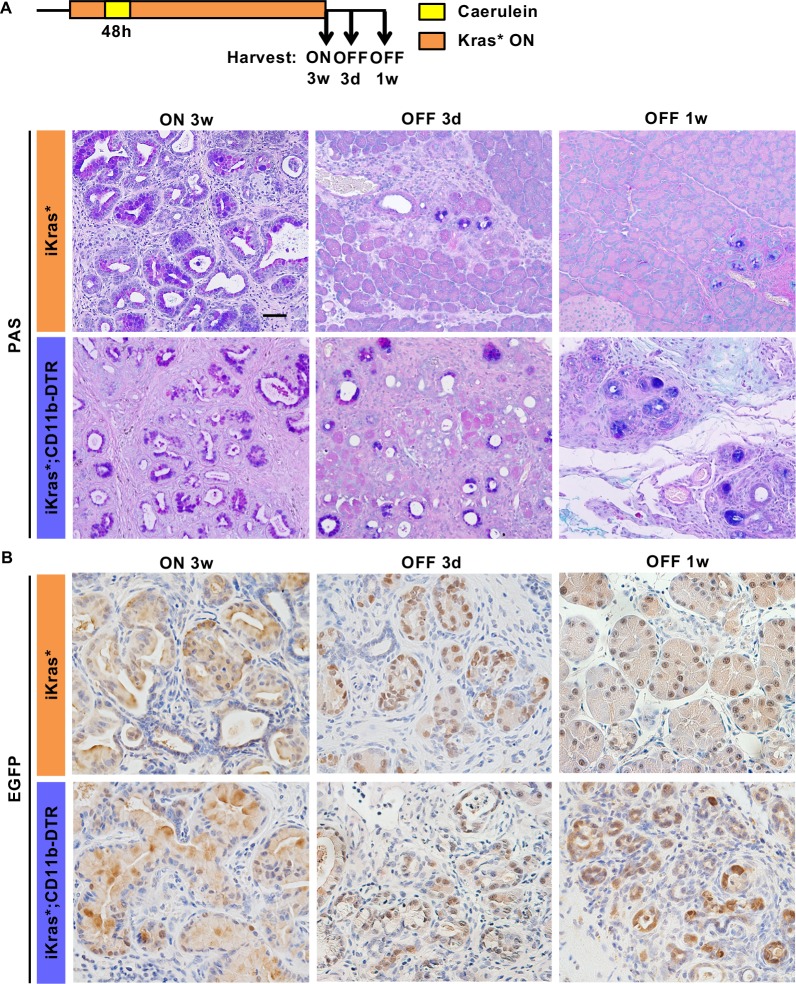
Myeloid cells are required for pancreatic acinar cell re-differentiation upon Kras* inactivation.(A) Periodic acid–Schiff (PAS) staining; (B) EGFP immunohistochemistry staining in iKras* and iKras*;CD11b-DTR pancreata 3 weeks post pancreatitis induction and 3 days, 1 week upon Kras* inactivation and DT treatment. Scale bar 50 µm.